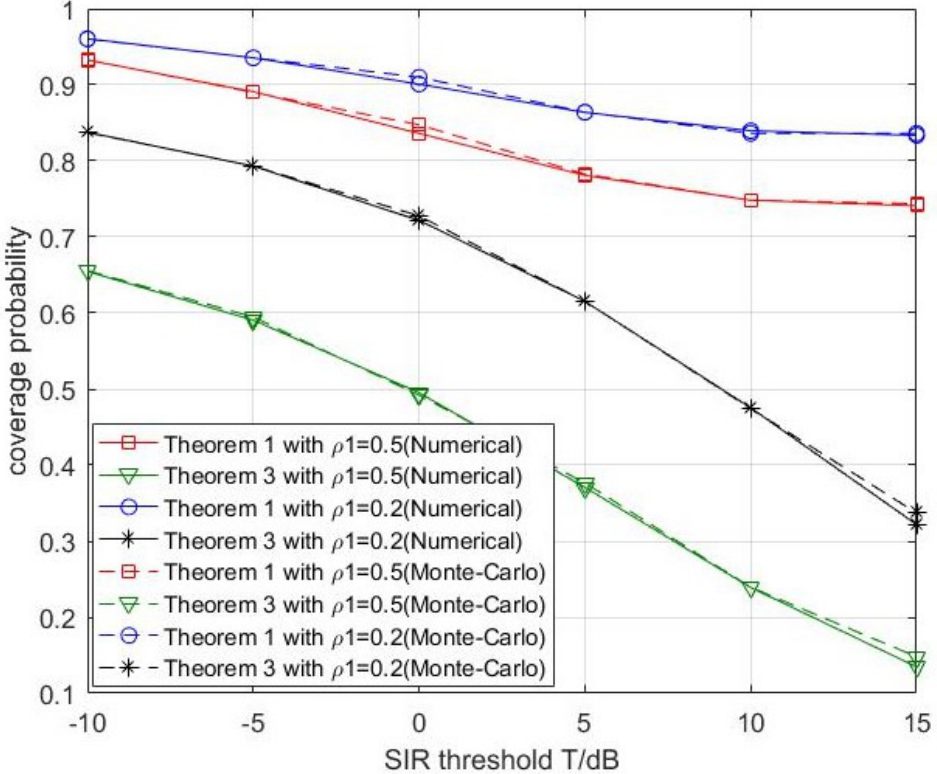
Figure 6. Comparison of analytical coverage probability expressions using the Poisson model versus Monte-Carlo simulations with ρ 2 =